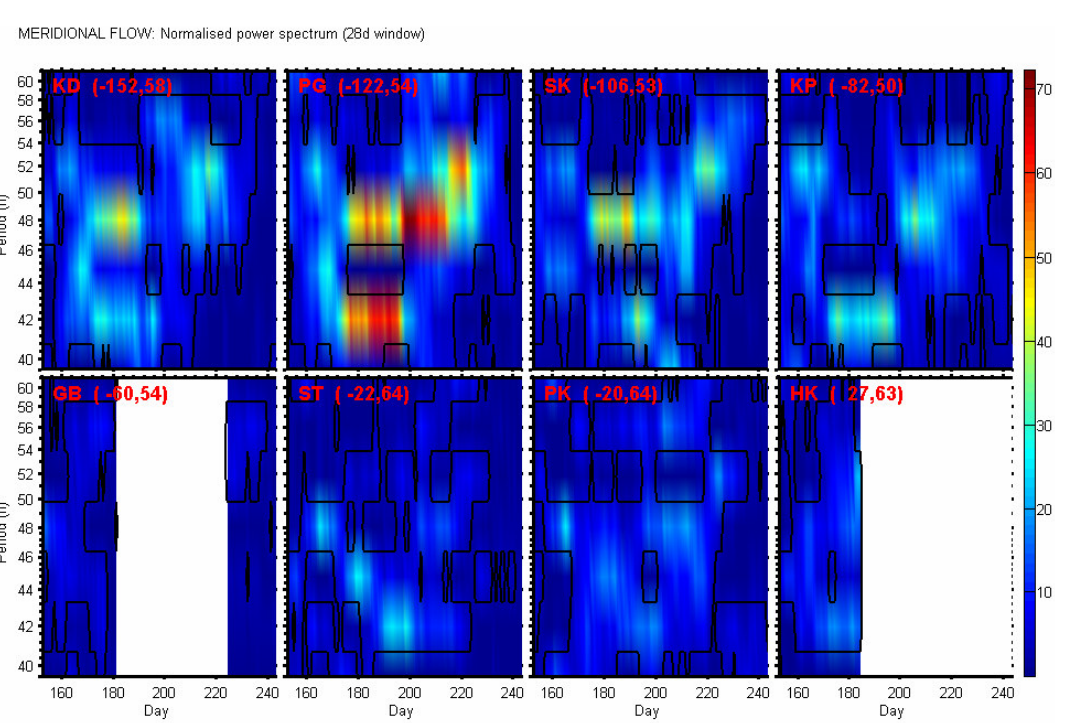
Figure 2. The normalised power spectrum for the meridional flow in summer for different radars, as indicated by the abbreviations on the top left-hand corner of each panel. The black contours represent the 95% confidence levels. ZONAL FLOW: Normalised power spectrum (28d window)